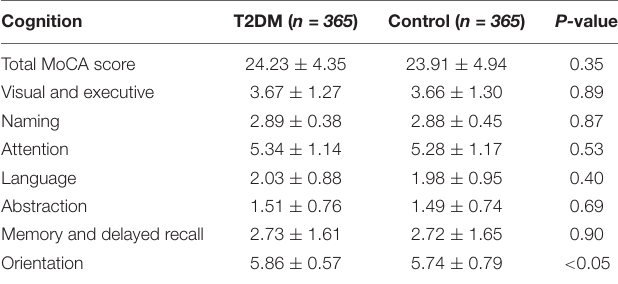
TABLE 3 | Comparison of cognitive function in subjects with type 2 diabetes mellitus (T2DM) and control